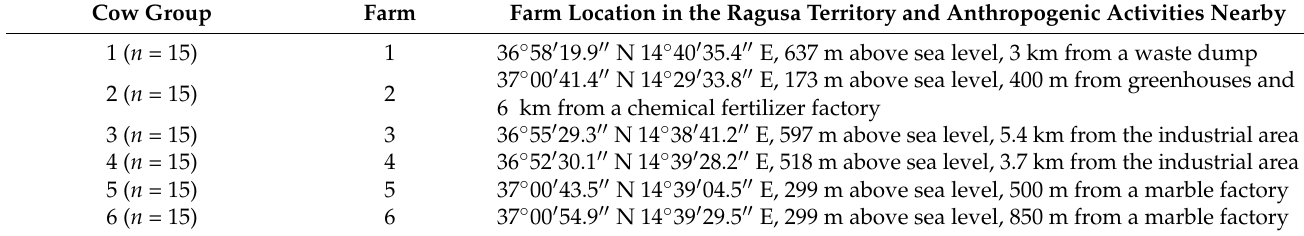
Table 1. Farm origin of cow groups in the Ragusa area with anthropogenic activities nearby. Cow Group Farm Farm Location in the Ragusa Territory and Anthropogenic Activities